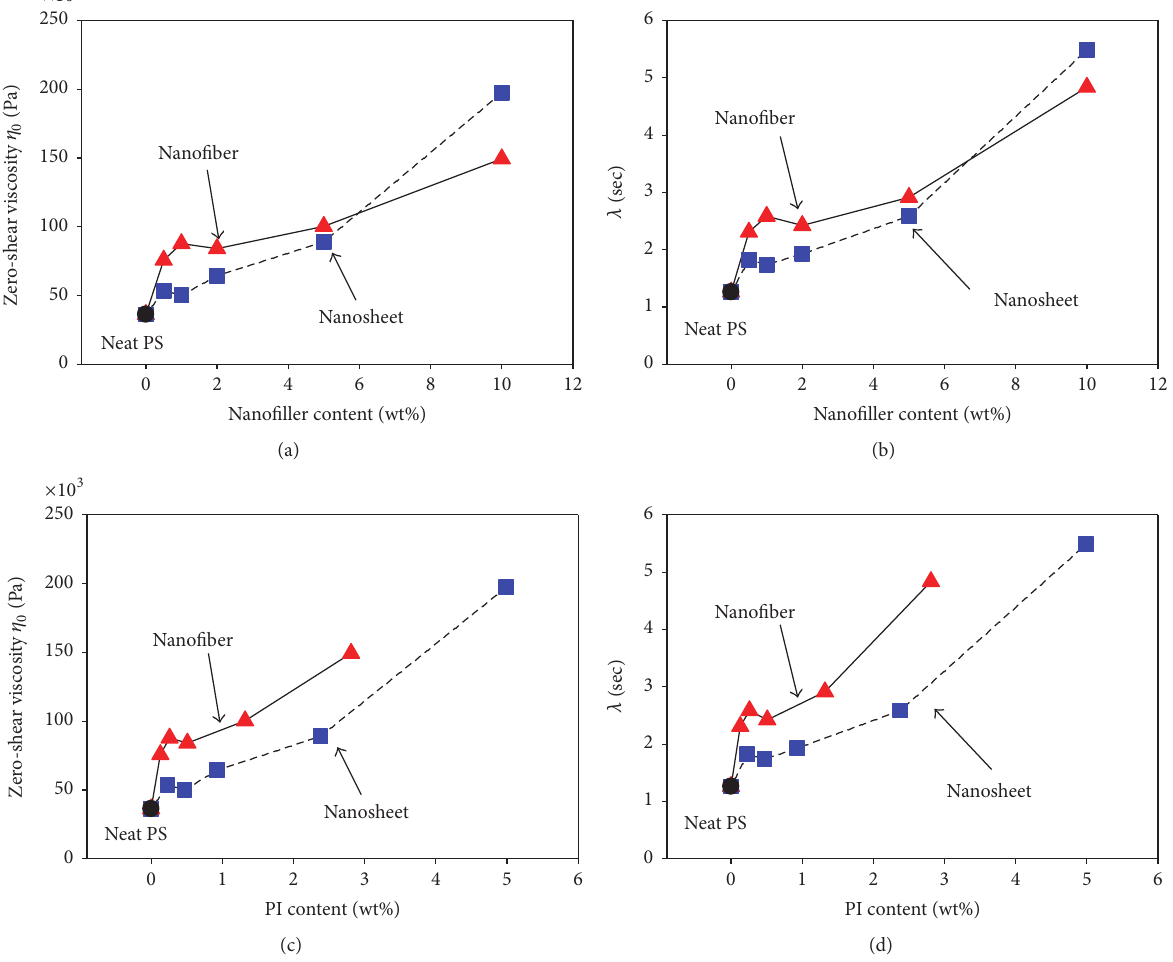
Figure 7: Relaxation time (a) and zero-shear viscosity (b) versus filler content plotted by model fitting data. (c) and (d) are plotted using PI content. Solid line with triangle and dashed line with rectangular indicate PS/nanofiber and PS/nanosheet blend, respectively. Table 3: Calculated results using Cross-Williamson three-parameter model for zero-shear viscosity, relaxation time, and power-law exponent with neat PS, nanofiber blend, and nanosheet blend with varying nanofiller loading. Parameters